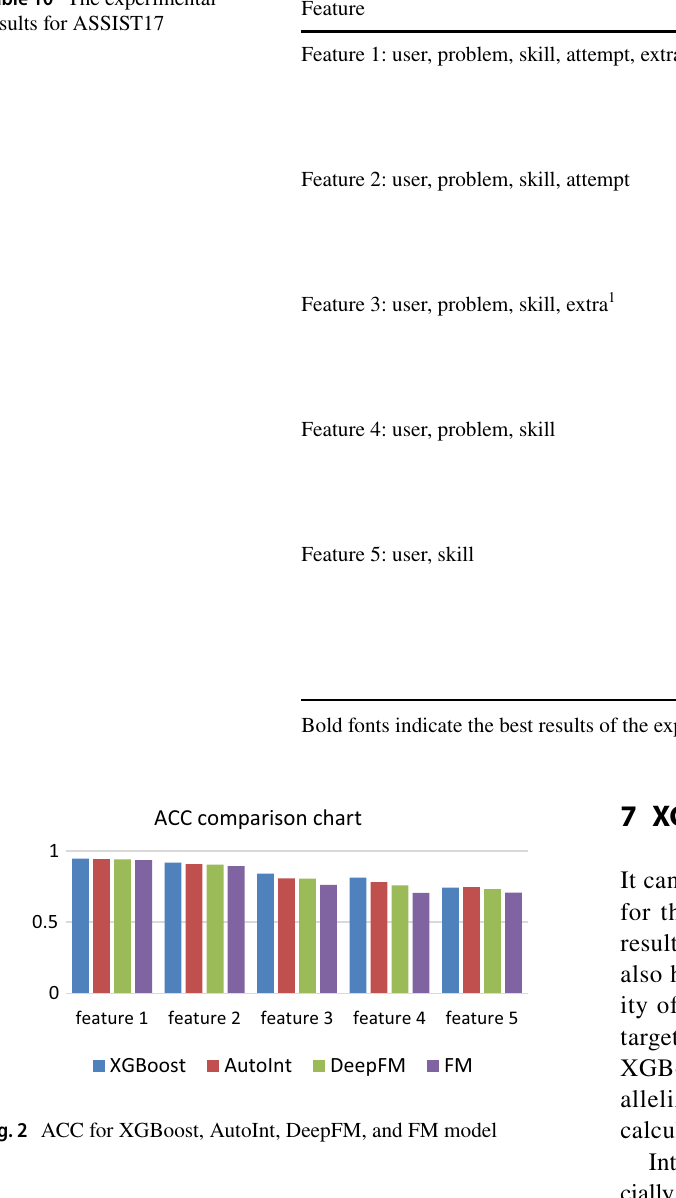
Table 10 The experimental results for ASSIST17